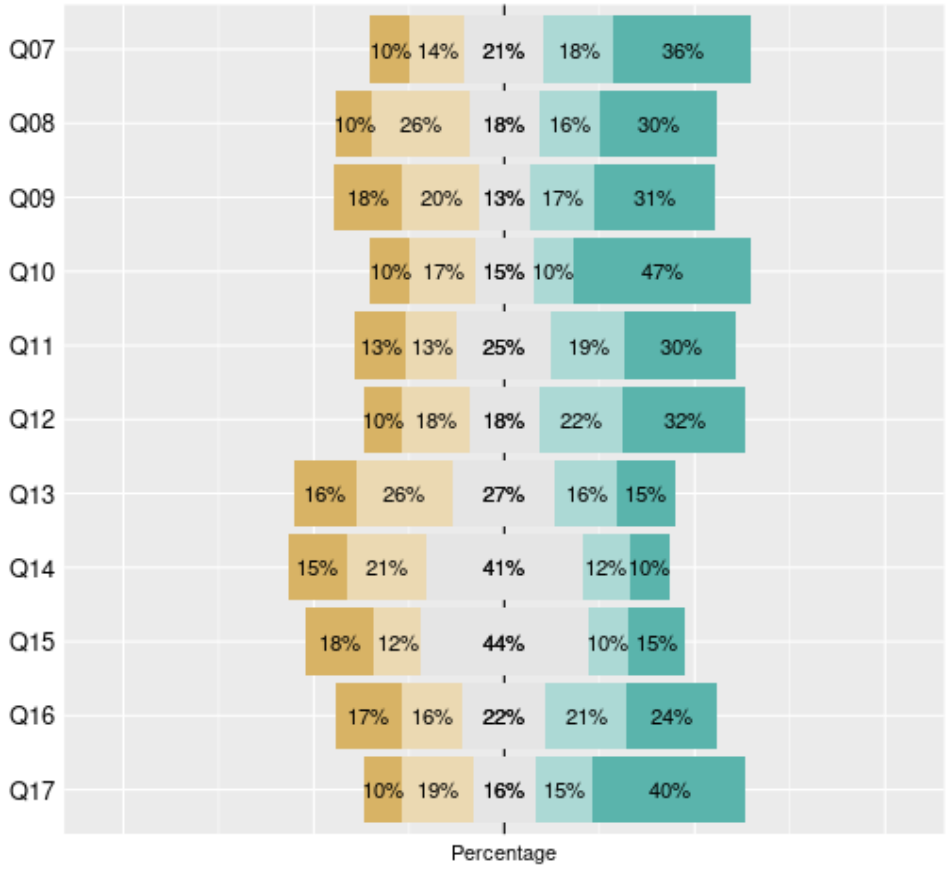
Figure 3. Results related to the governance